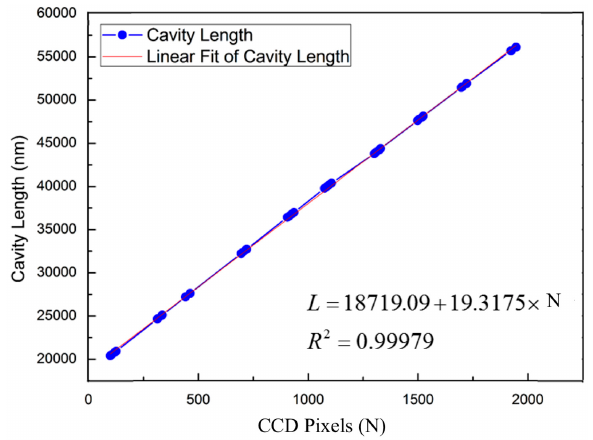
Figure 13. The calibration result of demodulation cavity corresponding to charge coupled device (CCD) pixel.